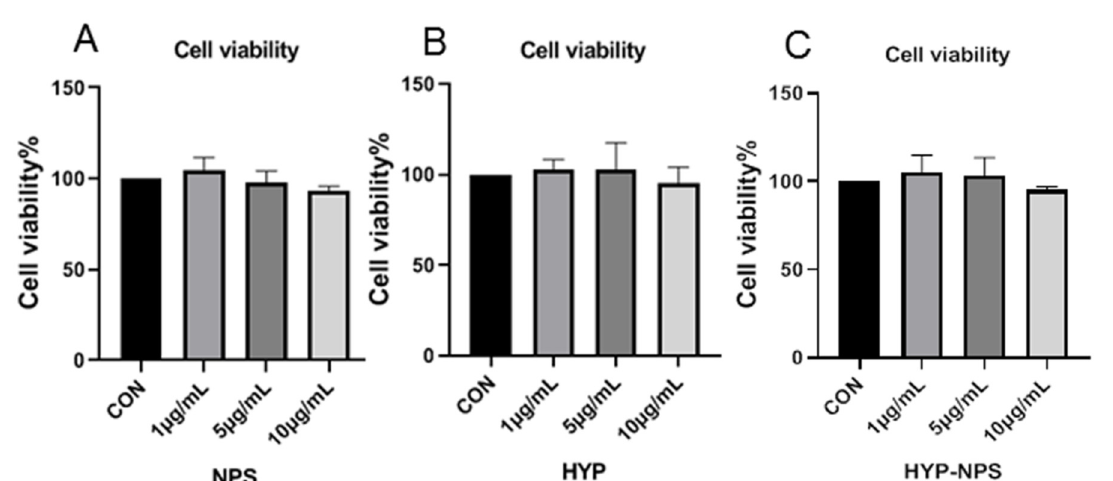
Figure 3. Biocompatibility assessment of NPS, HYP, and HYP-NPS.